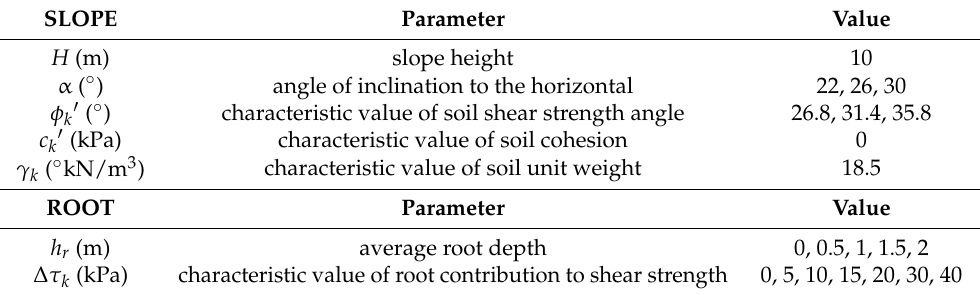
Table 3. Root-reinforced slopes’